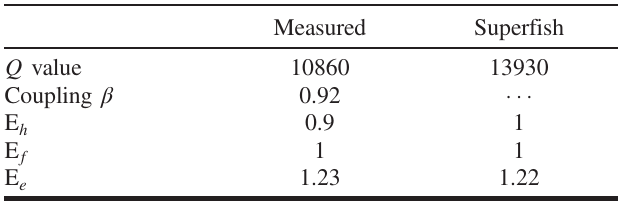
TABLE IV. Results of low power rf characterization compared to Superfish.